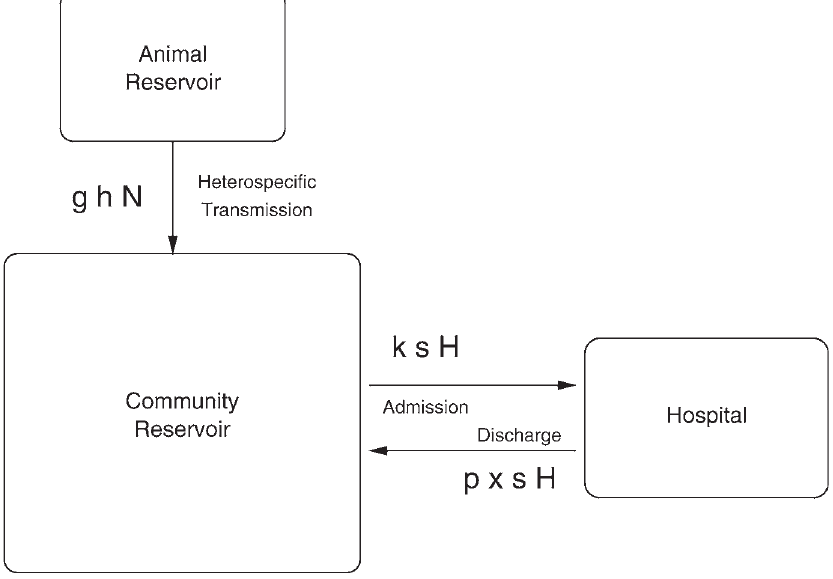
Figure 2. How Large Is the Impact of Antibiotic Use in